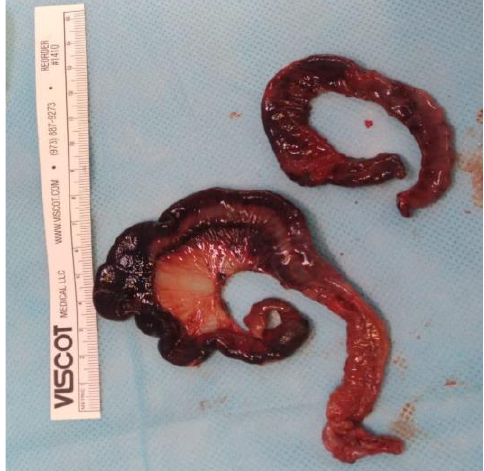
Figure 2: Resected specimens from both the intussusceptions with no pathological lead points grossly There were no pathological lead points. Histopatholo- gy of excised segments showed full-thickness hemor- rhagic necrosis only. Postoperatively, feeds were started on the fifth day and progressed gradually. He recovered well and was discharged. Subsequent eval- uation for syndromic associations was done due to dysmorphic facies, post-axial polydactyly, cardiac anomaly, thymic hypoplasia, and hypocalcemia. Fluo- Table 1: Summary of cases of simultaneous Intussusception in neonates reported in English literature.